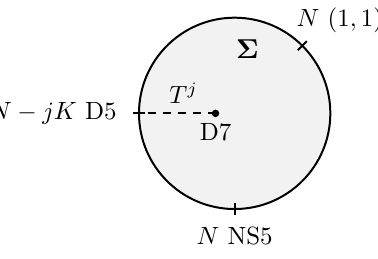
Figure 3 . 5-brane webs for the T N;K;j theory with N = 4, K = 2, j = 1. On the left hand side as a constrained triple junction, on the right hand side with the 7-branes inside the web.